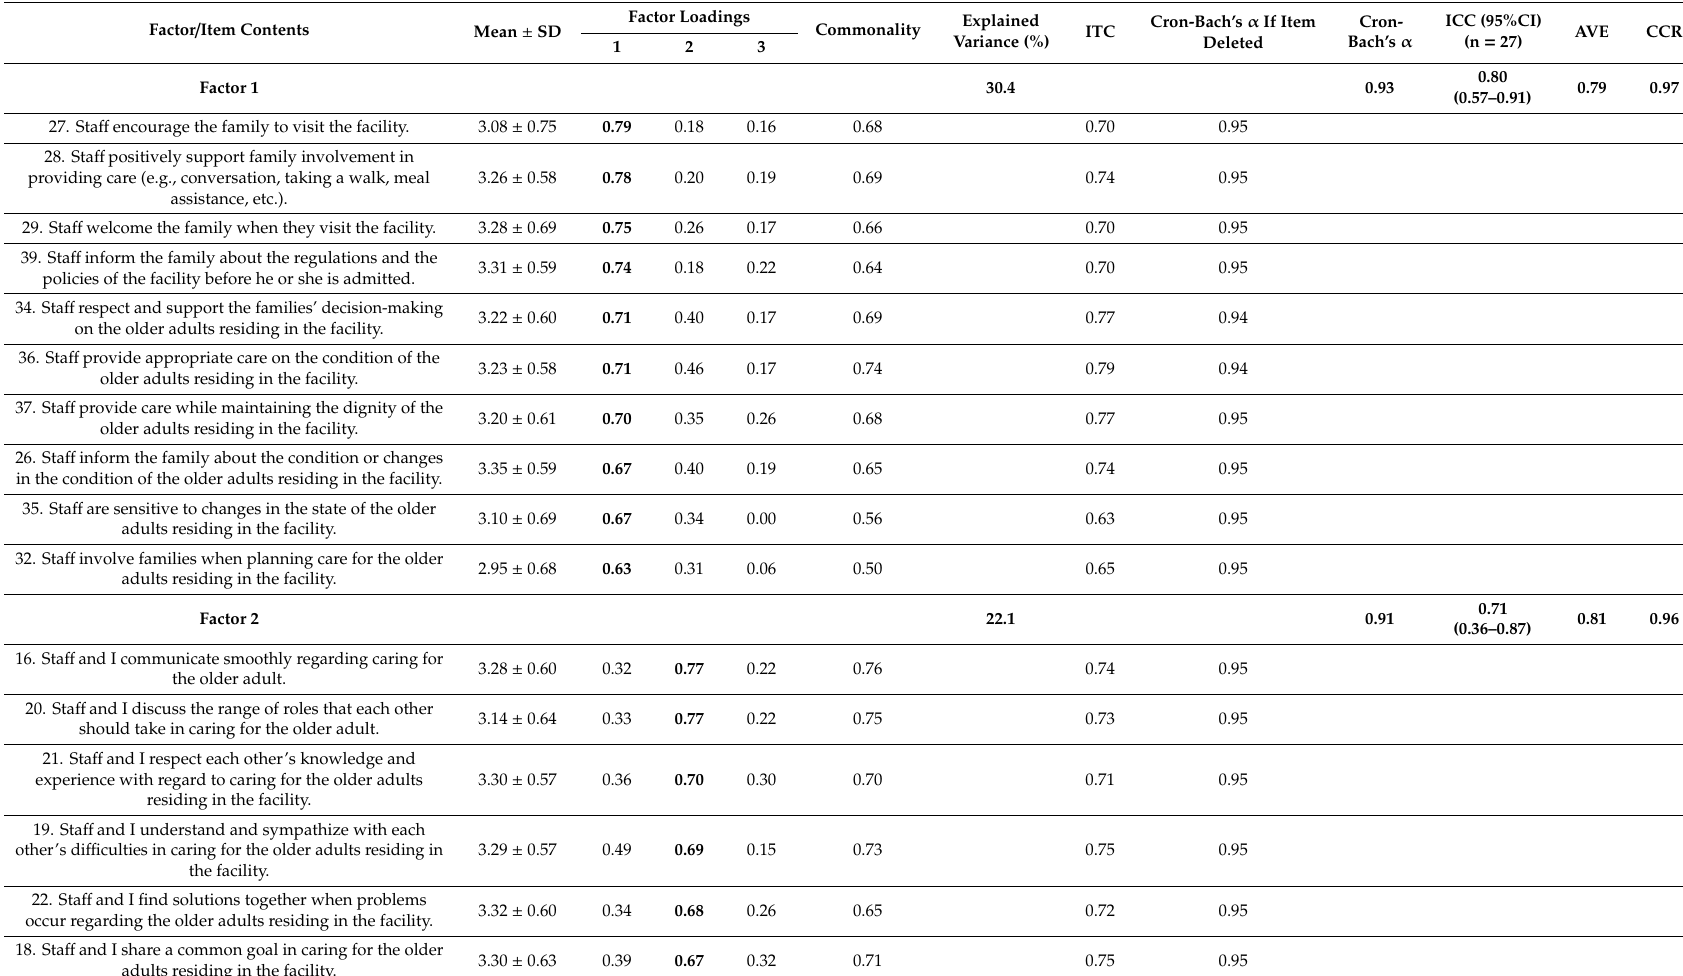
Table 2. Item analysis and factor analysis of Scale for Partnership In Care—for Family